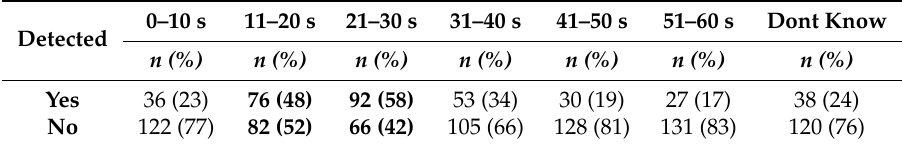
Table 4. Scenario three detection rate (syn attack).